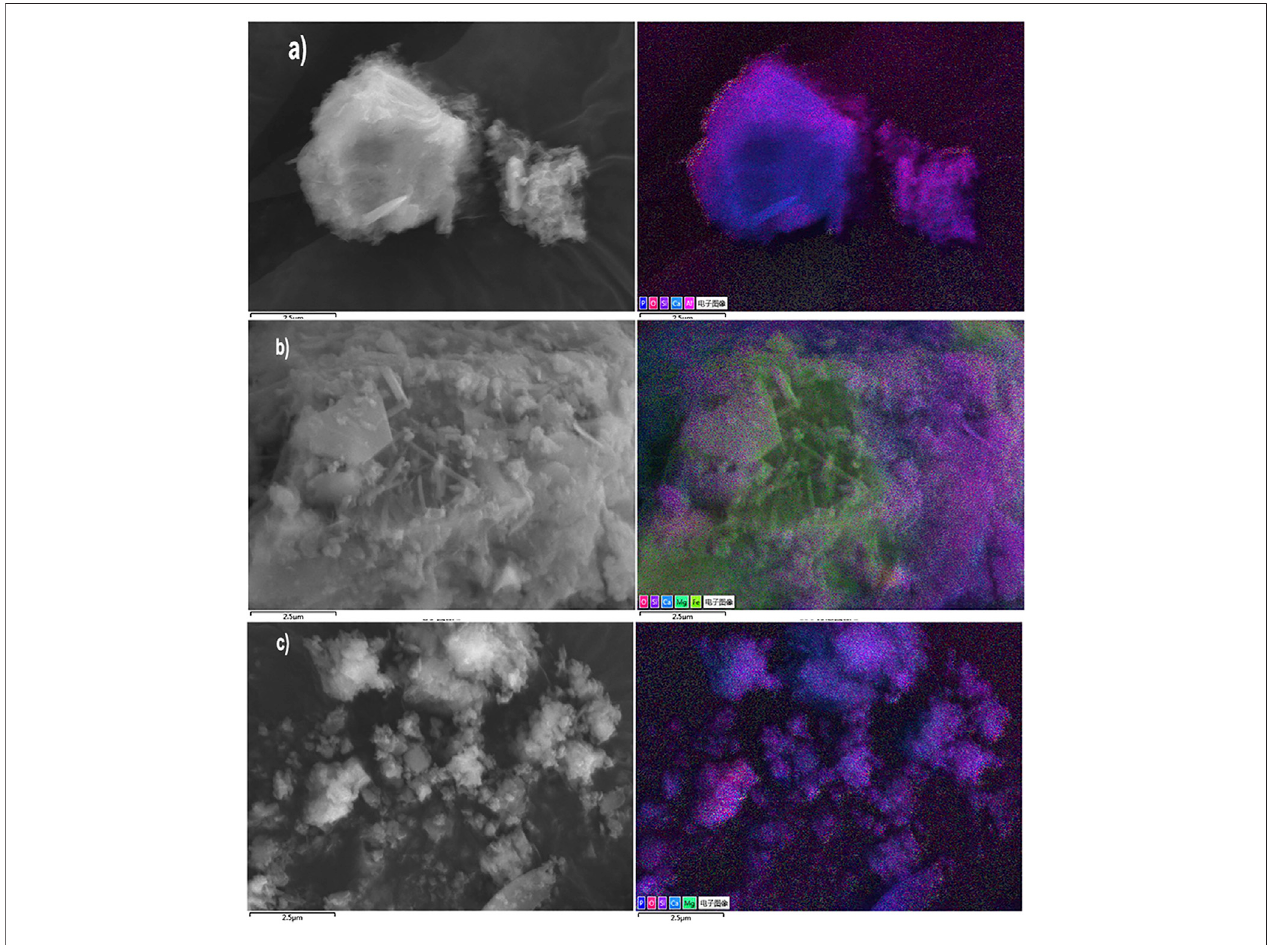
FIGURE 8 | SEM-EDS images of the uncarbonated area sample from A2A-28d (A) , carbonated area samples from A2C-1d (B) , and C2C-1d (C) .